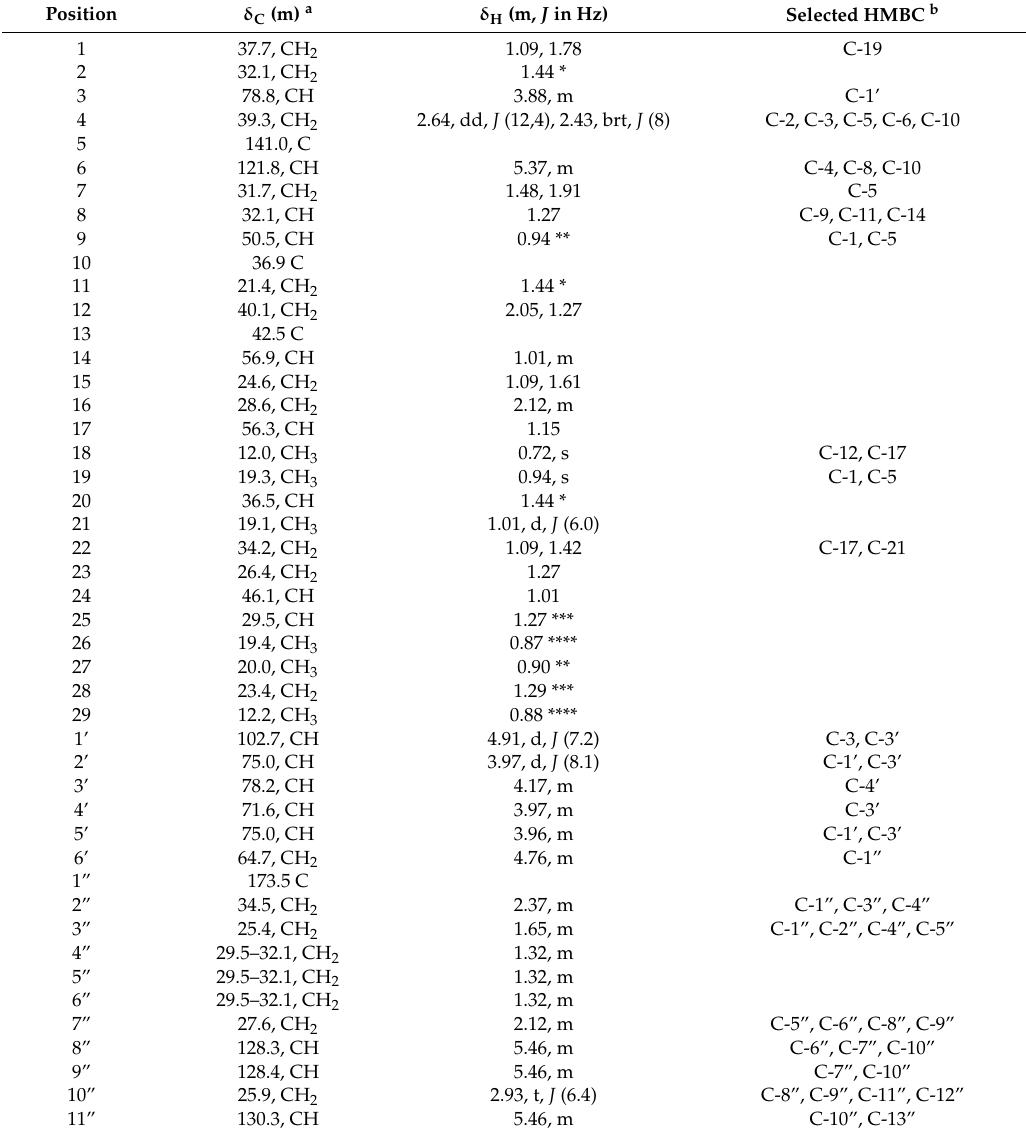
Figure 2. Selected HMBC and COSY correlations of compound 1.